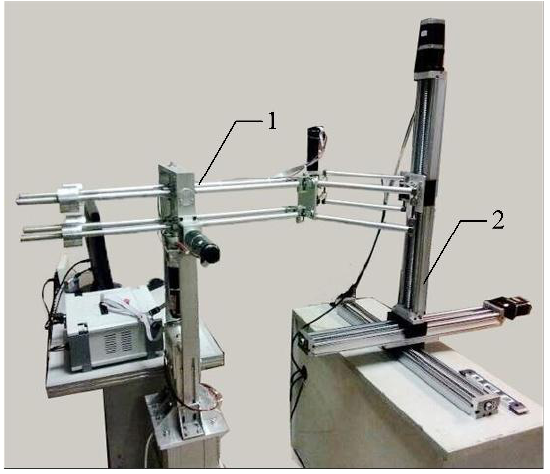
Figure 12. Setup of position tracking experiment ( 1 ) Haptic device; ( 2 ) Three dimensional electric sliding platform.